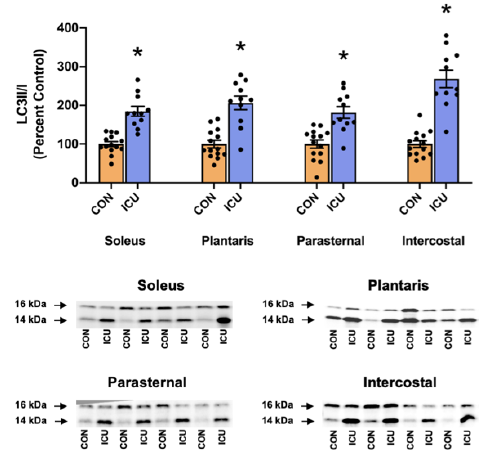
Figure 5. Ratio of LC3II/I as a marker of autophagy signaling. Ratio of LC3II/I in the soleus, plantaris, parasternal, and intercostal muscles of control, non ‐ anesthetized, non ‐ ventilated rats (CON), and rats that underwent 12 h of controlled mechanical ventilation (ICU). Representative Western blots are shown below the graph. Data are presented as mean ± SEM. * significantly different versus CON ( p < 0.05).